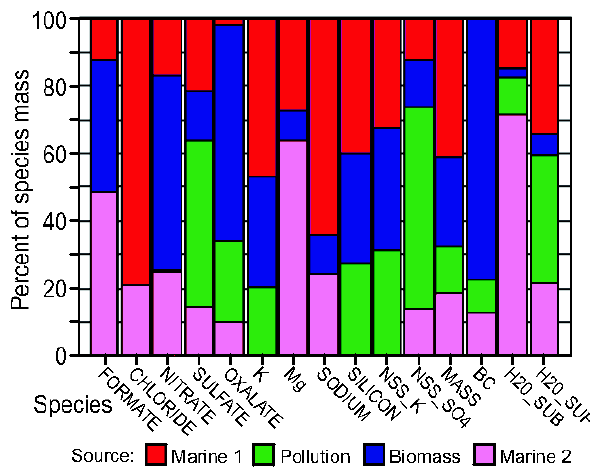
Figure 2. Source profiles for the four sources identified by the PMF model for the CARMA-IV (2007) data set.